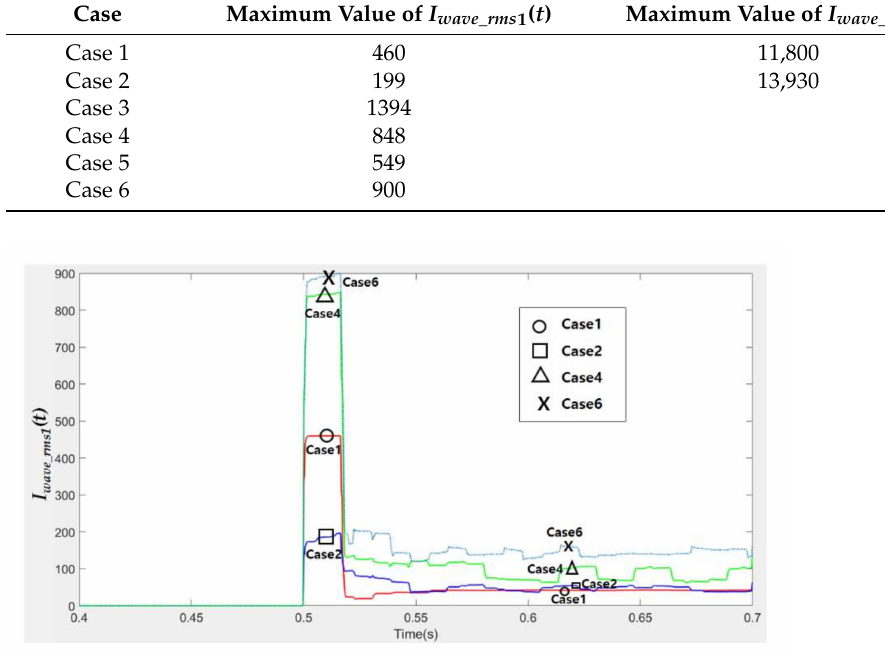
Figure 11. Comparison of I wave_rms 1 ( t ) in Cases 1, 2, 4, and